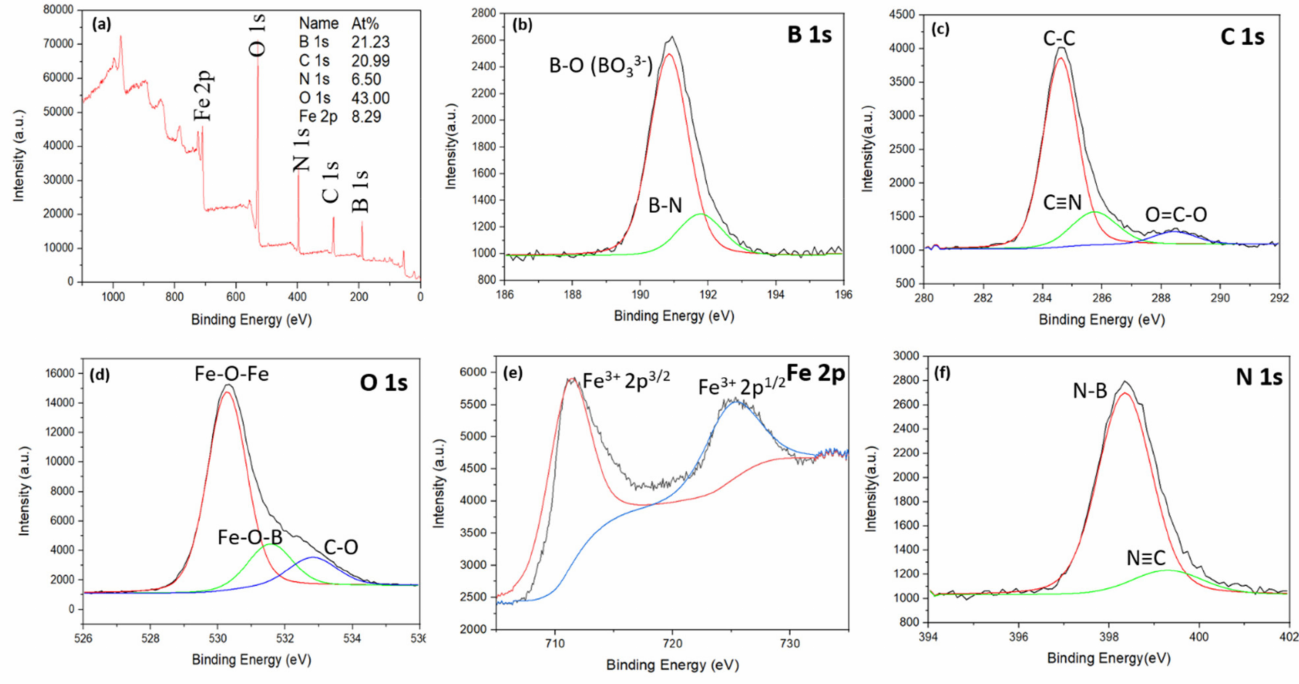
Figure 4. The XPS spectrum of the as-prepared C,N-doped FeBO 3 : ( a ) full survey spectrum, ( b – f ) Gaussian fitted B 1s ( b ), C 1s ( c ), O 1s ( d ), Fe 2p ( e ), and N 1s ( f )